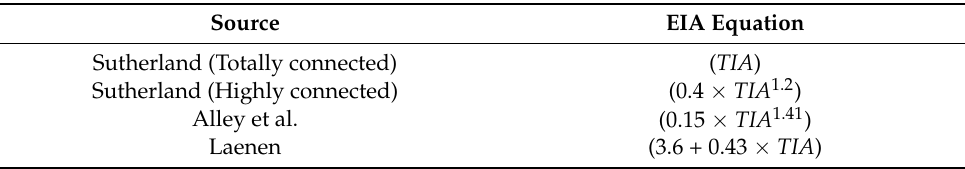
Table 3. EIA equations used in this